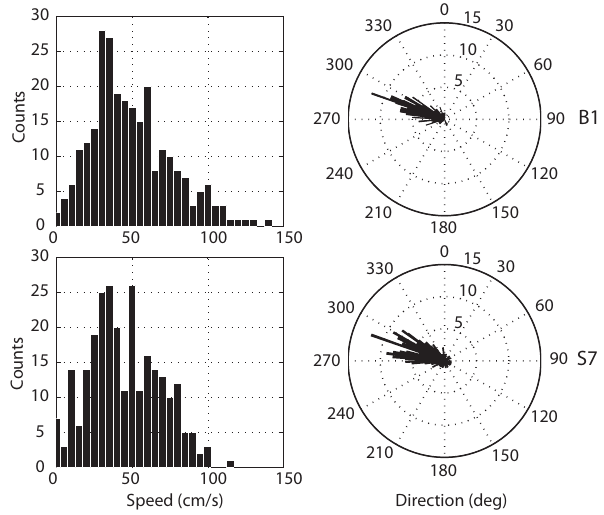
Fig. 7. Histograms of wave orbital velocity and direction for mooring B1 (top) and mooring S7 (bottom).